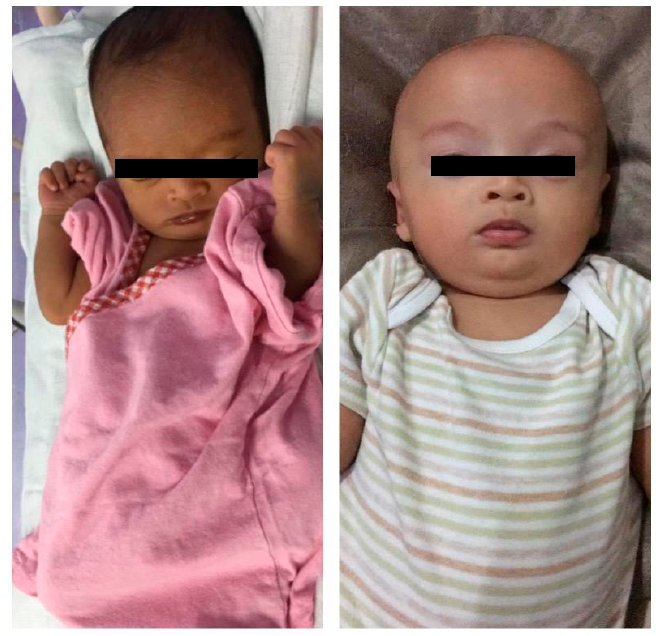
Figure 2. ( left )—Day 14 of life, ( right )—3-month-old (after treatment initiation). At birth, he had a dark complexion (Figure 3) with a birth weight of 2.6 kg (25th centile); there were no signs of dysmorphism or chest wall abnormality. He has normal male genitalia, but was darkly pigmented and there were bilateral undescended testes. His left testis was not palpate and the right testis was palpable at the inguinal canal with a volume of 1 mL. There were no other abnormalities such as sacral pit, developmental dysplasia of hip or rocker bottom feet. At three months, he was small for his age, with both weight and height below the third centile. He had head lag, was unable to roll-over, or bear weight on legs and hands. At 10 months of age, his fine-motor, personal social skills and language improved and he caught up for his age, except for gross motor skills, as he still had head lag.